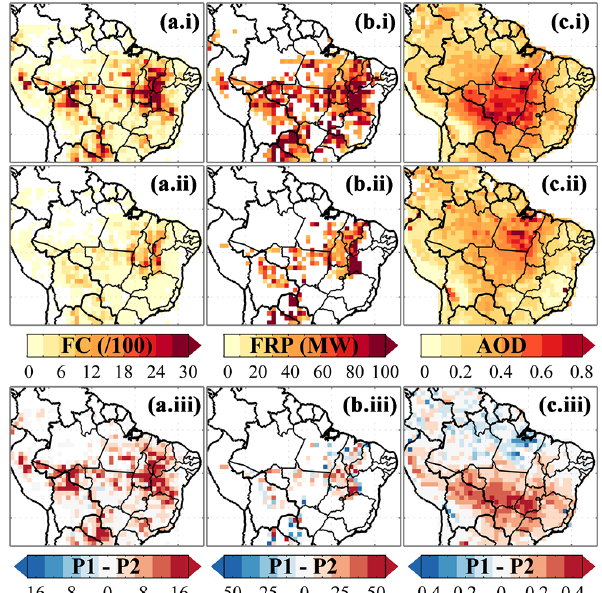
Figure 6. Meteorological phases 1 ( i ; dry season 14–22 Septem- ber 2012) and 2 ( ii ; dry–wet transition 23–5 October 2012) me- dian total fire count (FC; a ) and fire radiative power (FRP; b ) from MODIS active fire detections, calculated over a 1 ◦ grid. Meteoro- logical phases 1 ( i ; dry season) and 2 ( ii ; dry–wet transition) median aerosol optical depth (AOD; c ) from MODIS 1 ◦ product. The dif- ference between these periods is illustrated in panels (iii)